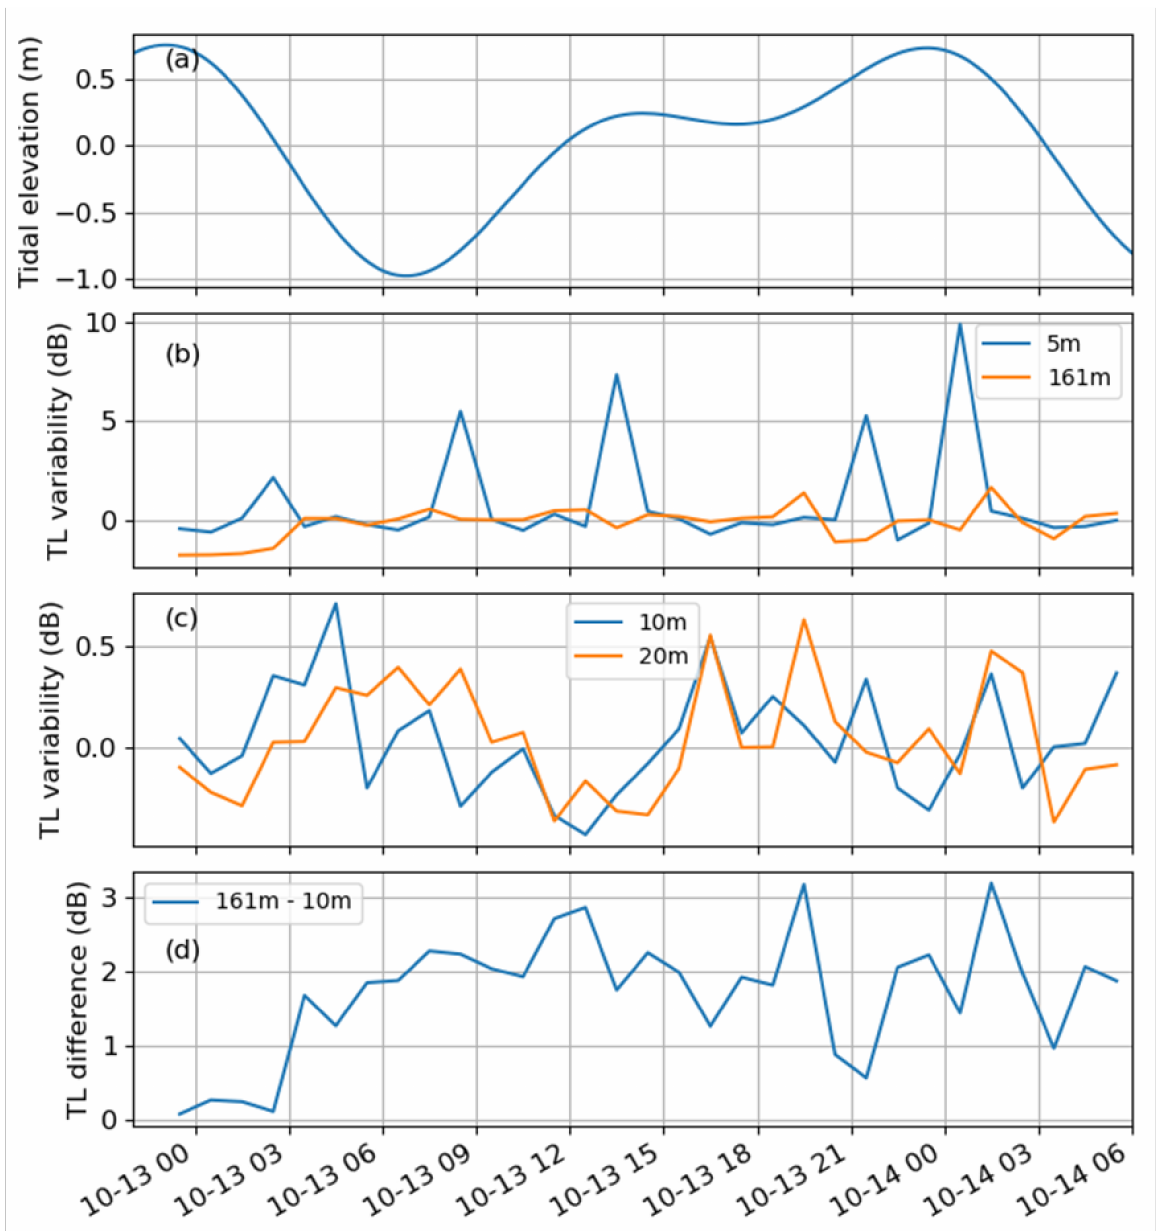
Figure 8. Tidal elevation at the Sooke mooring ( a ); modeled transmission loss (TL) variability at different depths ( b , c ); and the TL difference from modeled values between 161 m and 10 m depths ( d ). The acoustic frequency modeled was 10 kHz and the source depth was 2 m at a range of 3000 m south of the mooring location, in the middle of the outbound shipping